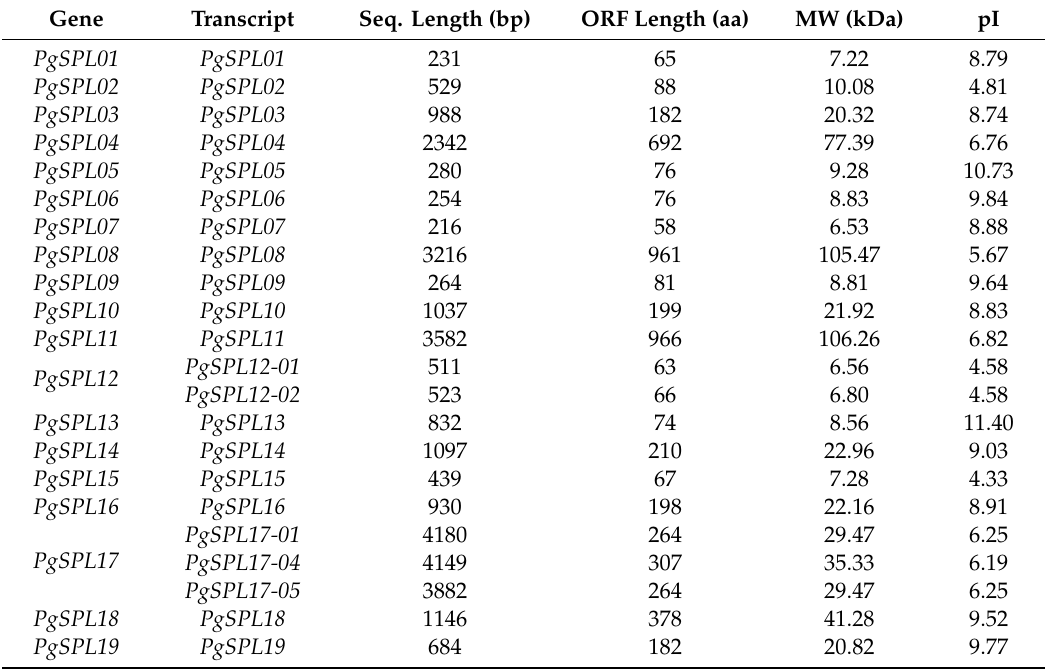
Table 1. PgSPL gene